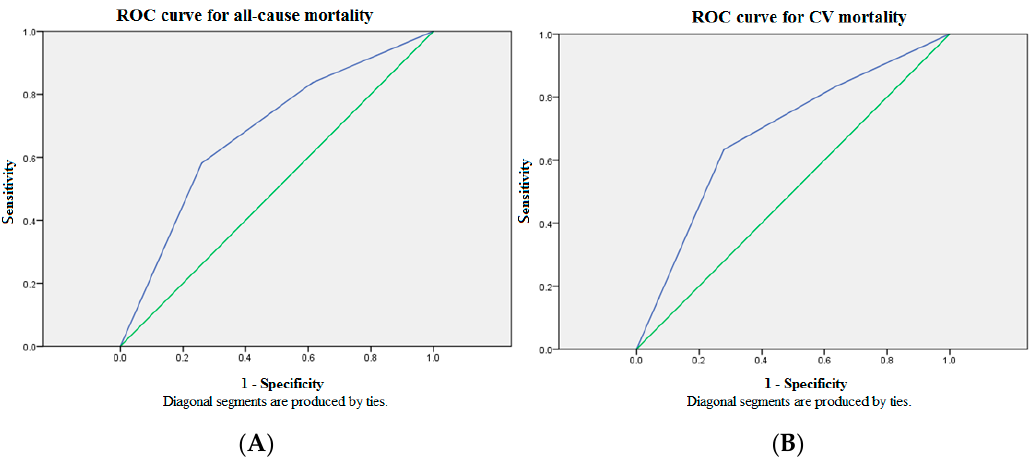
Figure 2. The ROC analysis of GDF15 tertiles for mortality showed suboptimal discriminatory power in the whole study population over 30 months of follow-up. ( A ) The AUC provided by GDF15 tertiles for all-cause mortality was 0.681 (95% CI = 0.589 to 0.774, p < 0.01). ( B ) The AUC provided by GDF15 tertiles for CV mortality was 0.684 (95% CI = 0.577 to 0.791, p < 0.01). Source of the curve: green line = GDF15 tertiles; blue line = reference. AUC = area under curve; CV = cardiovascular; GDF15 = growth differentiation factor-15; ROC = receiver operating characteristics.